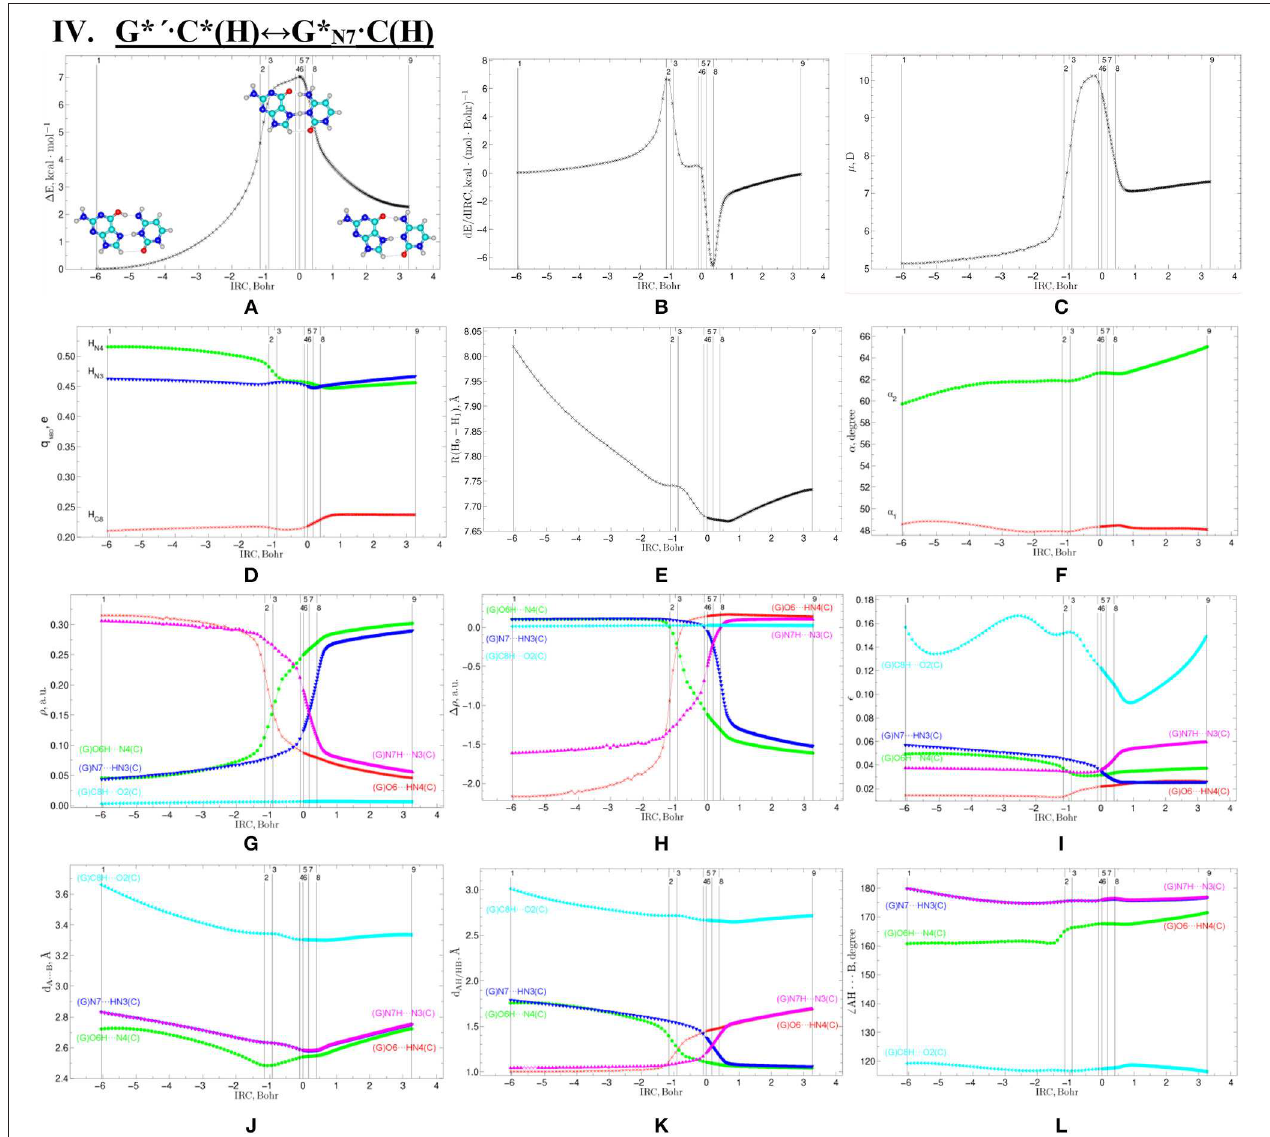
FIGURE 9 | Profiles of the physico-chemical parameters of the investigated IV. G* ′ B3LYP/6-311 G(d,p) level of theory in vacuum. For more detailed designations see Figure 3 ++